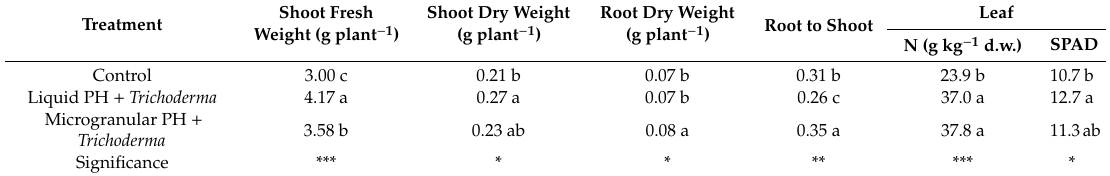
Table 3. E ff ect of biostimulant treatments on dry weight of shoots and roots, root to shoot ratio and nitrogen content, and Soil-Plant Analysis Development (SPAD) index of leaves in lettuce transplants (Experiment